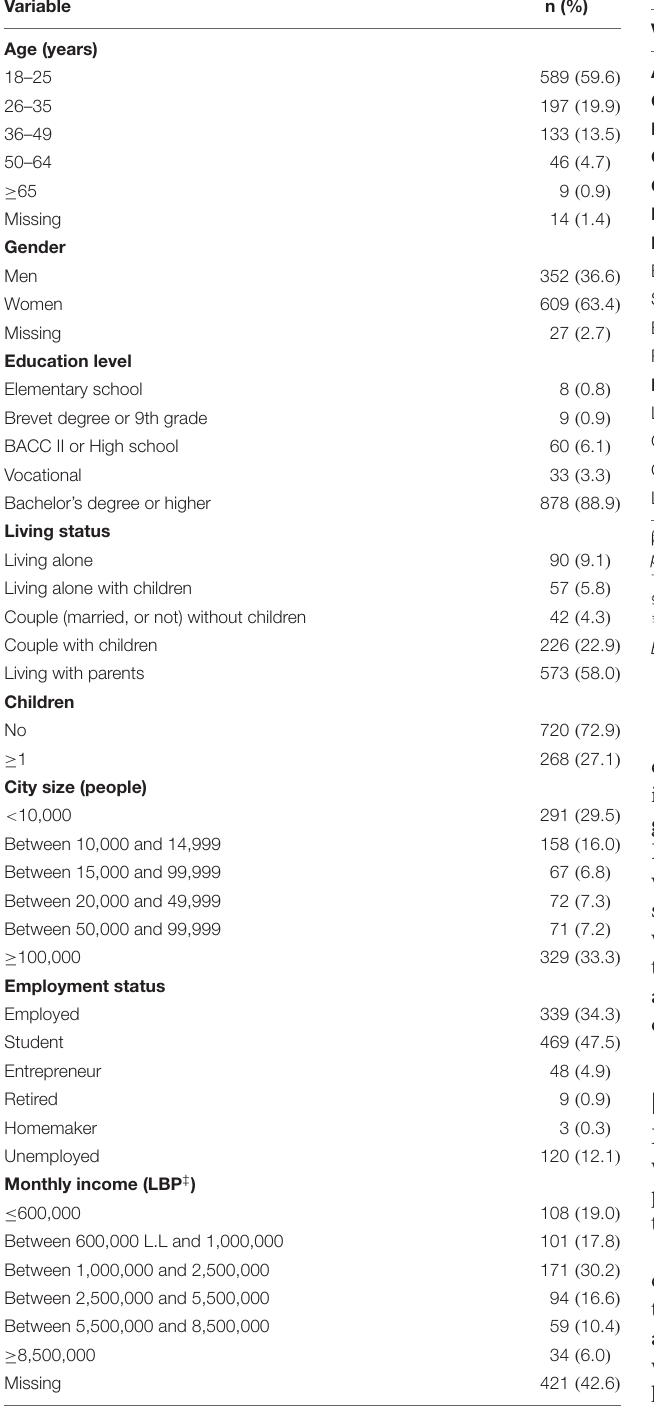
TABLE 2 | Regression analysis to explain relationships between personal economic worries and